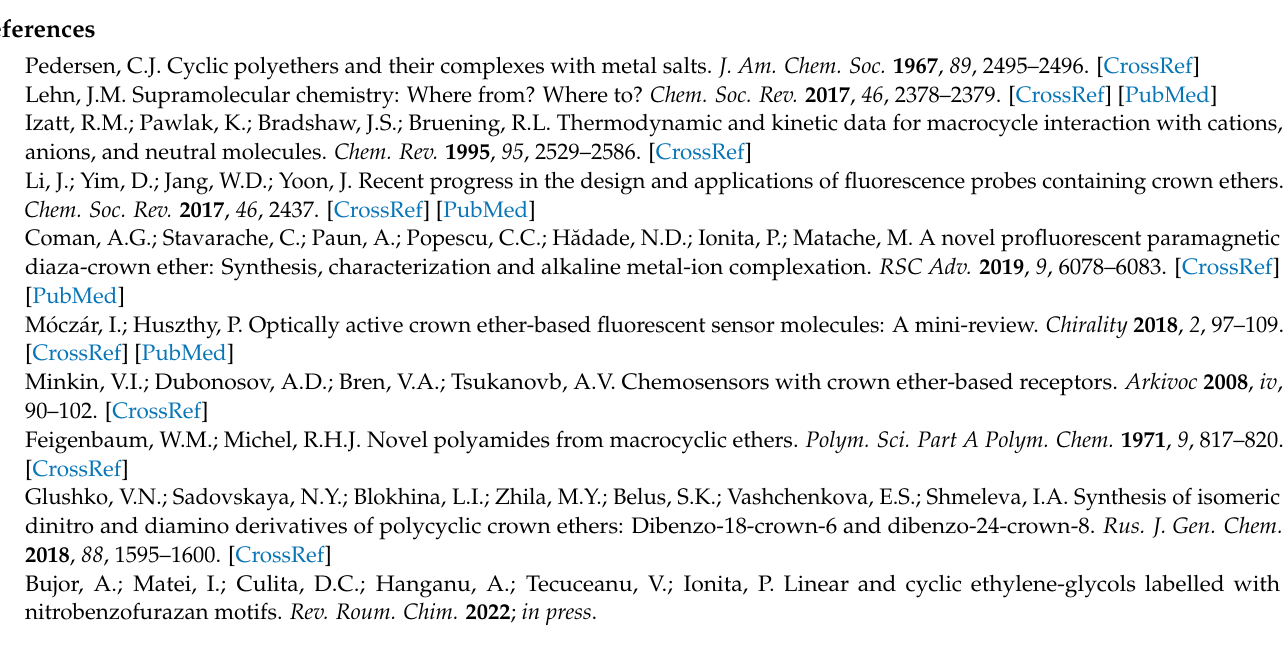
Figure S3: 13 C-NMR spectrum of DN-DB18-C-6 recorded in chloroform- d ; Figure S4: 1 H-NMR spectrum of DA-DB18-C-6 recorded in DMSO- d 6 ; Figure S5: 13C -NMR spectrum of DA-DB18-C-6 recorded in DMSO- d 6 ; Figure S6: 1 H-NMR spectrum of bis -NBD-DB18-C-6 recorded in DMSO- d 6 ; Figure S7: 13 C-NMR spectrum of bis -NBD-DB18-C-6 recorded in DMSO- d 6 ; Figure S8: IR spectrum of bis -NBD-DB18-C-6; Figure S9: UV-Vis spectrum of bis -NBD-DB18-C-6: Figure S10: Full (+)ESI-MS spectrum of bis -NBD-DB18-C-6, showing the formation of the supramolecular